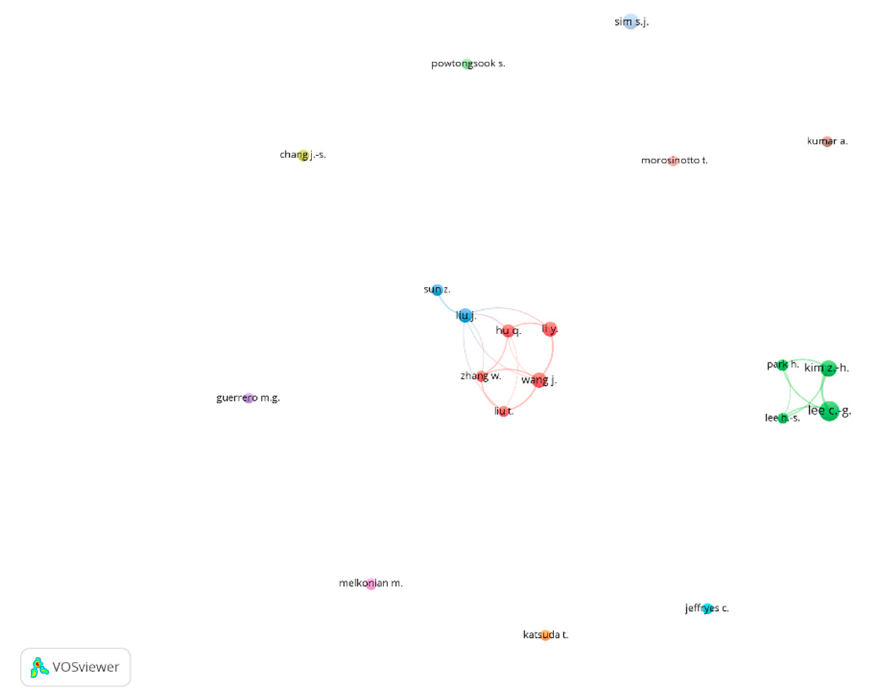
Figure 7. Authors’ contribution visualization.